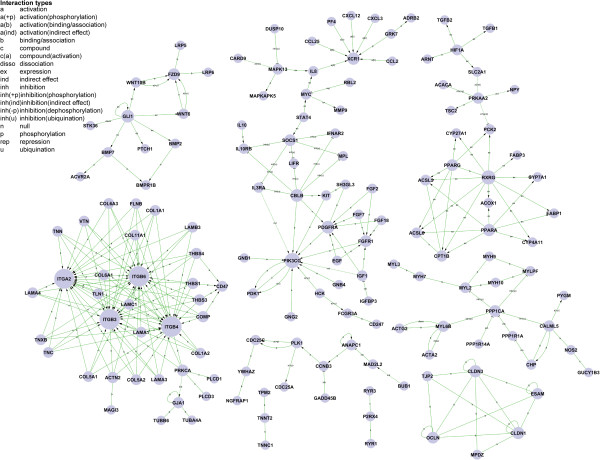
Gene-gene interaction network. Genes from significant profiles were analyzed and identified by signal-net construction. Cycle nodes represent genes, the size of nodes represents the power of the interrelation among the genes, and edges between two nodes represent interactions between genes (arrowheads represent targets). The more edges of a gene, the more genes connecting to it, and the more central role it has within the network.